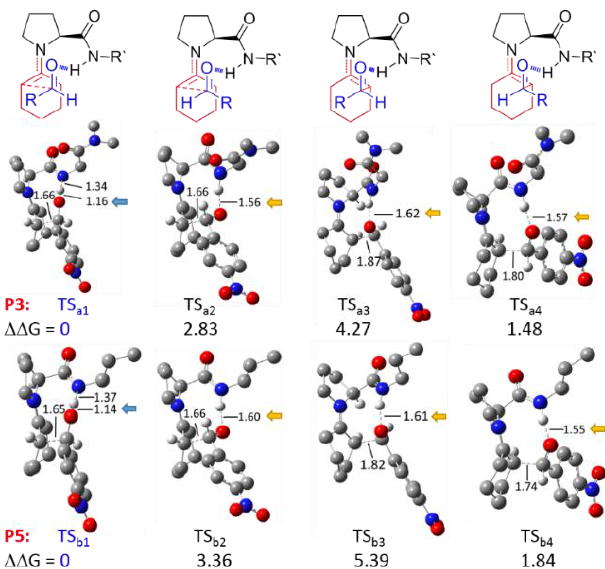
Figure 2. Optimized enamine / aldehyde reaction transition states in the P3 - / P5 -catalyzed aldol addition of cyclohexanone to 4-nitrobenzaldehyde in the absence of acidic additives. Relative energy barriers (in kcal / mol) and relevant geometric parameters are shown (in Å). Partial hydrogen atoms are hidden for clarity.